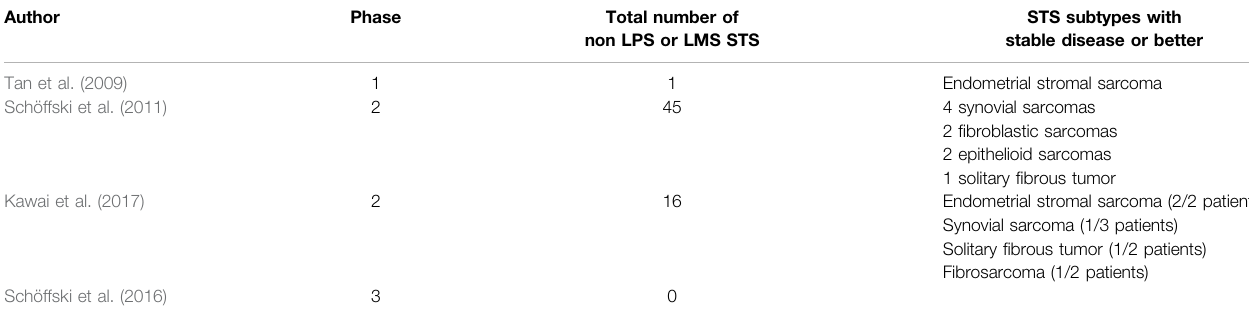
Table 2 . In a real-world observational study of 256 Japanese patients, eribulin was shown to have antitumor activity against multiple subtypes (Kobayashi E. et al., 2019).